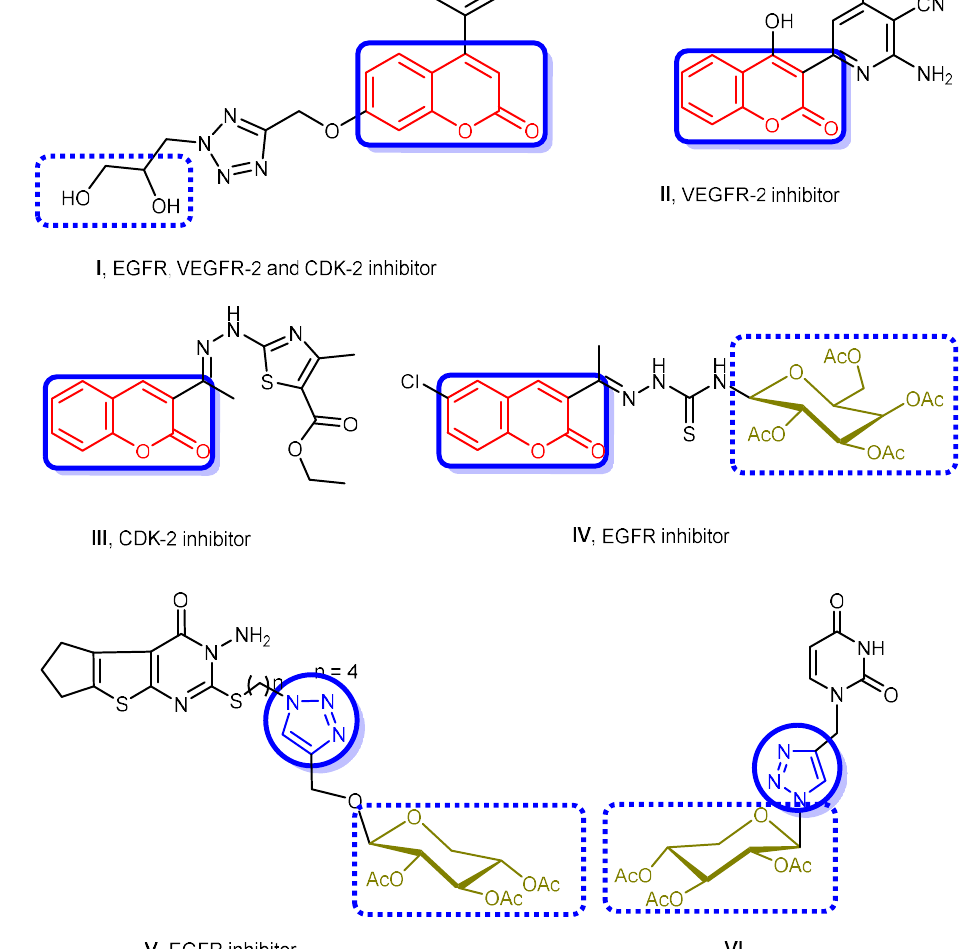
Figure 1. Some reported anticancer agents bearing coumarin, triazole and/or glycoside moieties with various mechanisms.